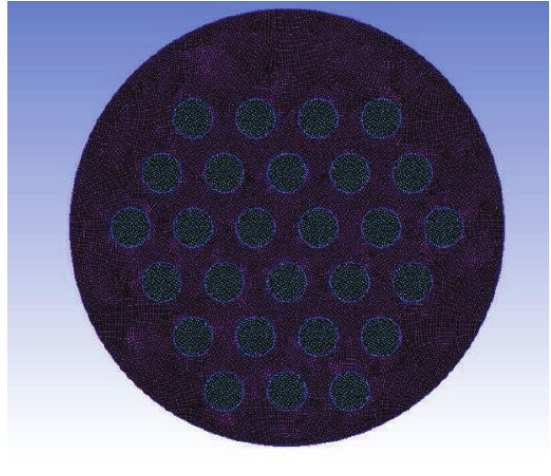
Figure 7: Underwater vehicle battery compartment